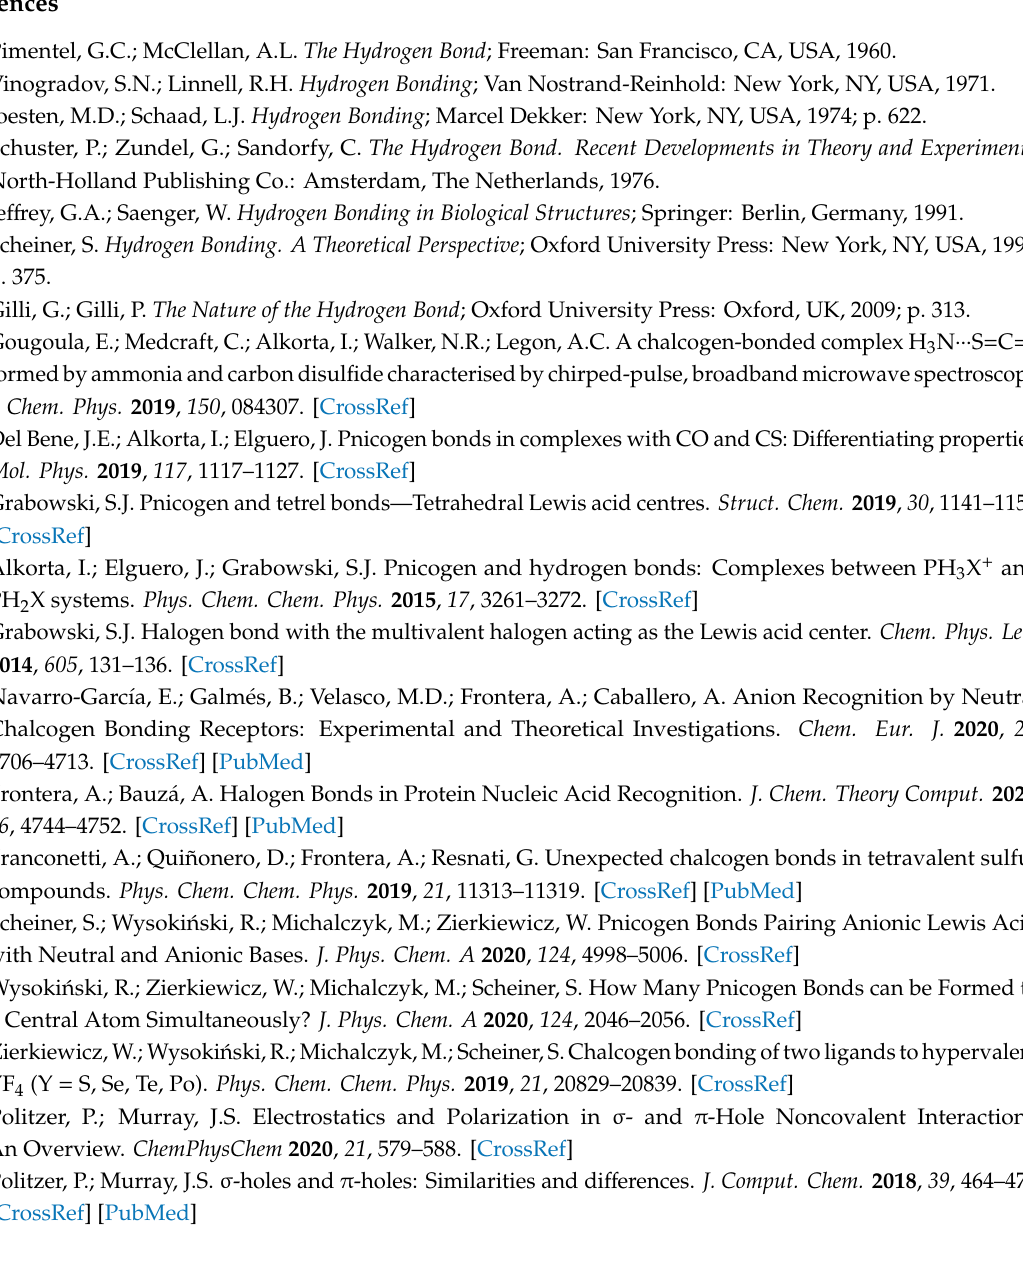
Supplementary Materials: The following are available online, Figure S1: AIM bond paths in complexes of NH 3 with (CN) 3 C-C(CN) 3 , Figure S2: Overlap of NH 3 N lone pair orbital, Figure S3: AIM bond paths in complexes of NH 3 , Figure S4: AIM bond paths in complexes of NH 3 with